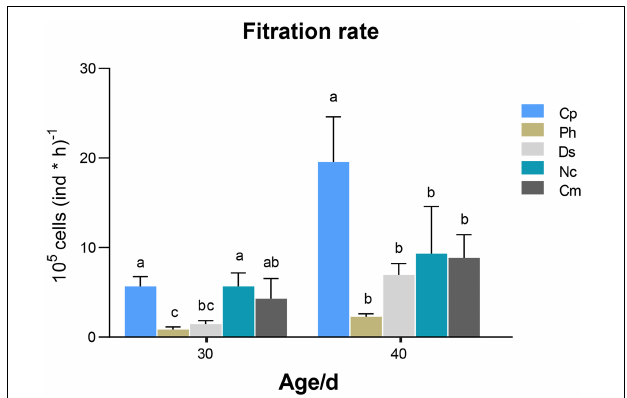
FIGURE 2 | Filtration rate (FR) of M. lateralis spat fed by different microalgae diets at different ages, different letters represent significant differences between different trials ( p < 0.05). Cp, Chlorella pyrenoidesa ; Ph, Platymonas helgolandica ; Ds, Dunaliella salina ; Nc, Nitzschia closterium ; Cm, Chaetoceros muelleri